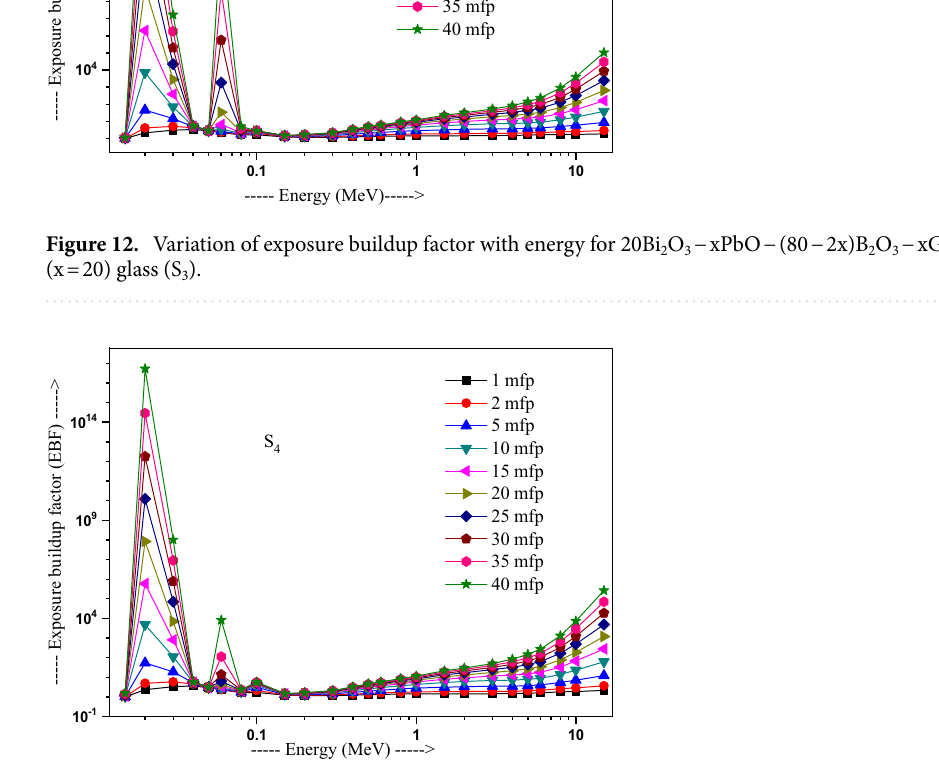
Figure 13. Variation of exposure buildup factor with energy for 20Bi 2 O 3 − xPbO − (80 − 2x)B 2 O 3 − xGeO 2 (x = 30) glass